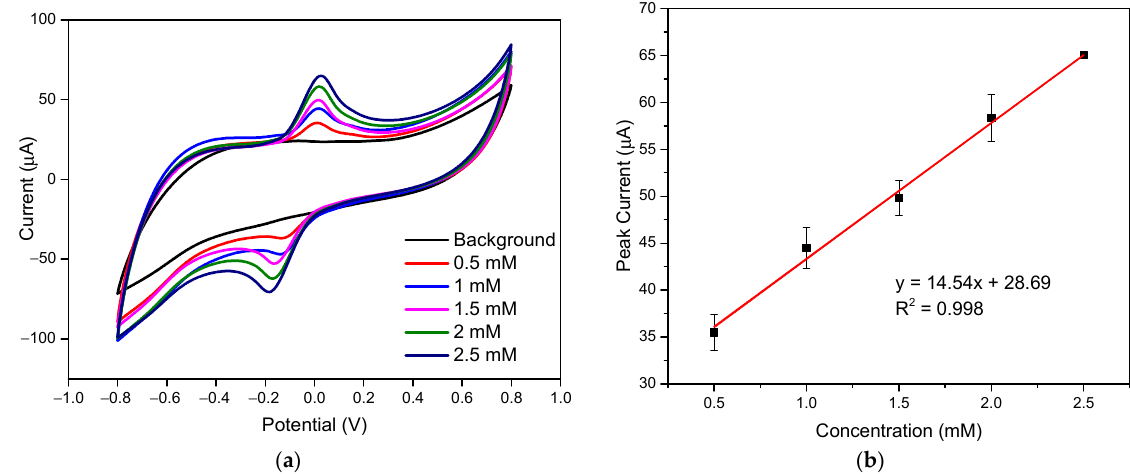
Figure 3. ( a ) CV responses of ferricyanide solutions with varying concentrations; and ( b ) oxidation current peaks vs. concentration. Scan rate was 50 mV s − 1 .